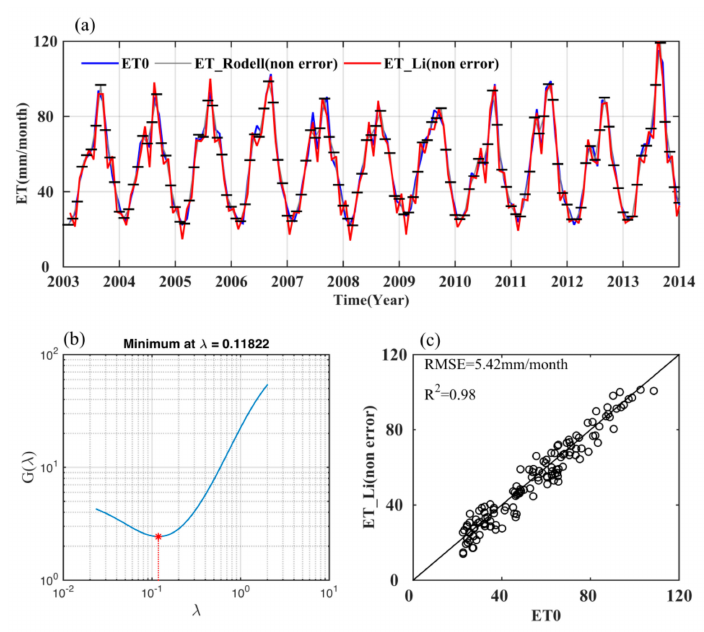
Figure 3. ( a ) Monthly ET estimated from simulated GRACE TWS and daily P and R observations without error using the method introduced in this study; ( b ) The regularization factor determined by the generalized cross validation (GCV) method; ( c ) The correlation ( R 2 ) and RMSE between the simulated ET observations and ET estimations using our method.